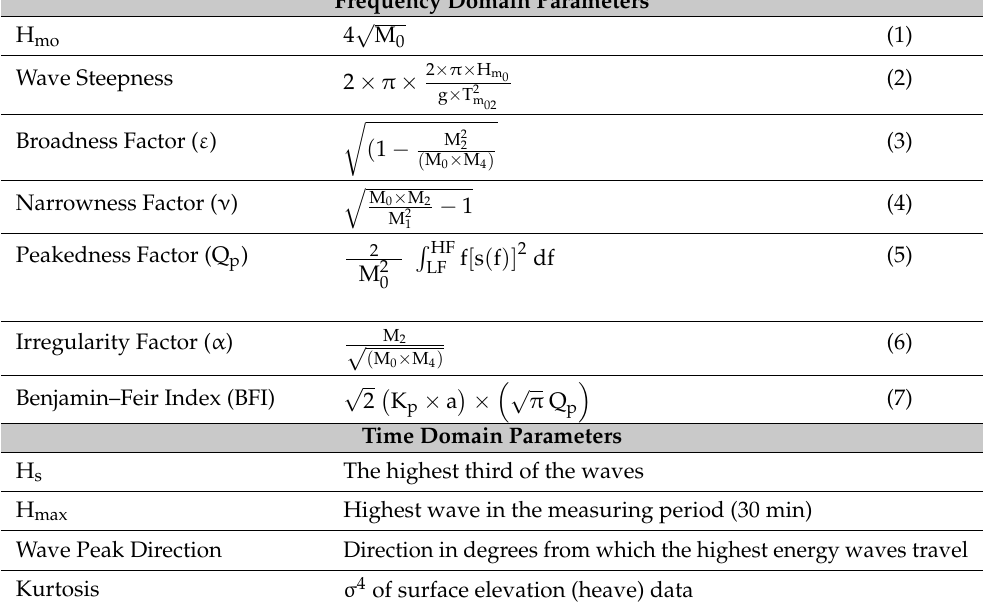
Table 2. A summary of the different wave parameters in the time and frequency domains that were analyzed in this paper, along with their descriptions and equations. Where σ is the standard deviation, M o , M 1 , M 2 and M 4 are the zeroth, first, second and forth spectral moments of the wave energy spectrum, respectively. K p is the peak wave number, a is the amplitude (H s /2) and the product K p × a is the wave steepness